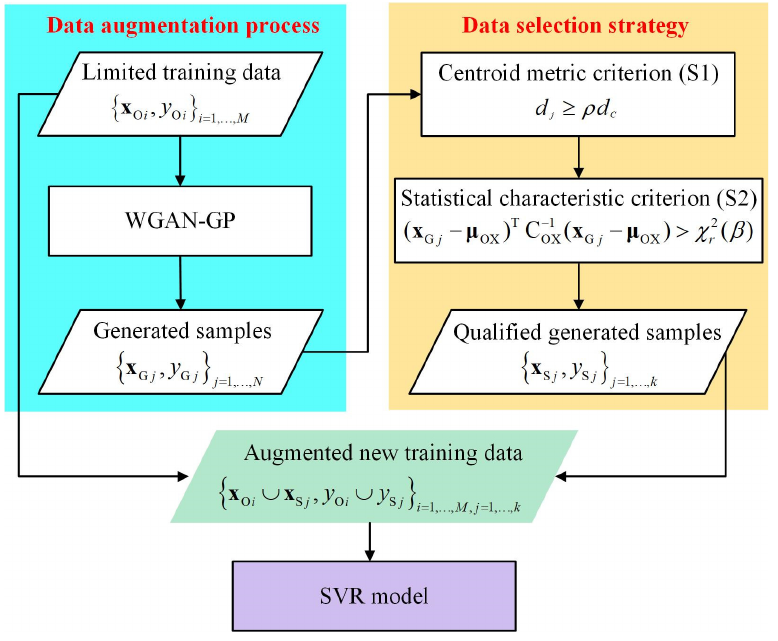
Figure 3. Flowchart of the proposed SWGAN-SVR method.